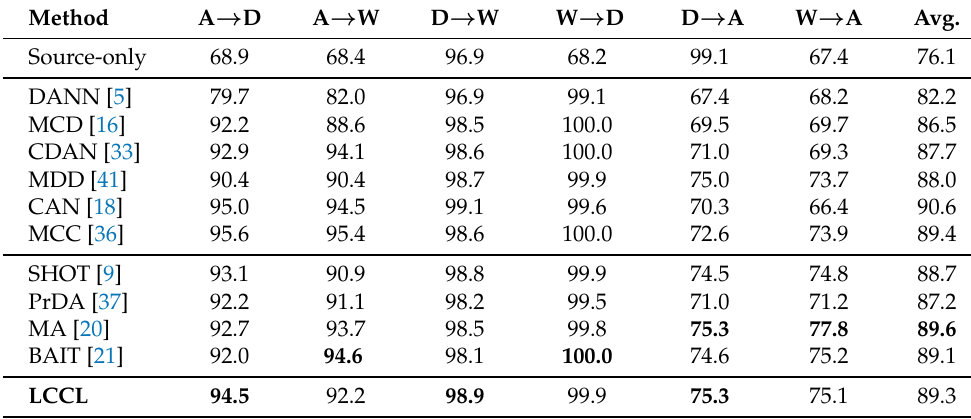
Table 3. Accuracies (%) on Office-31 dataset (ResNet-50).